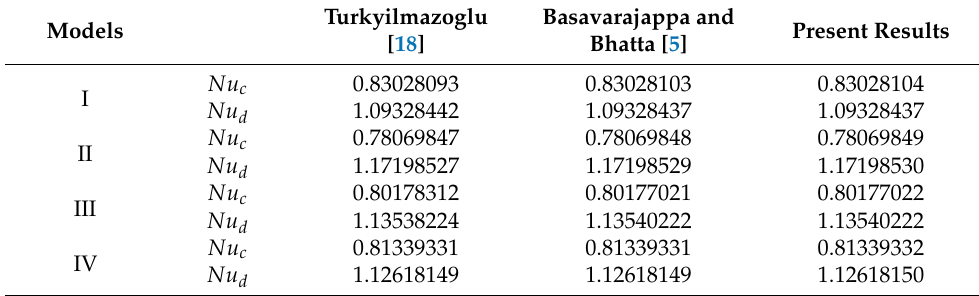
Table 2. Comparison of the current study with previous research for a few limited